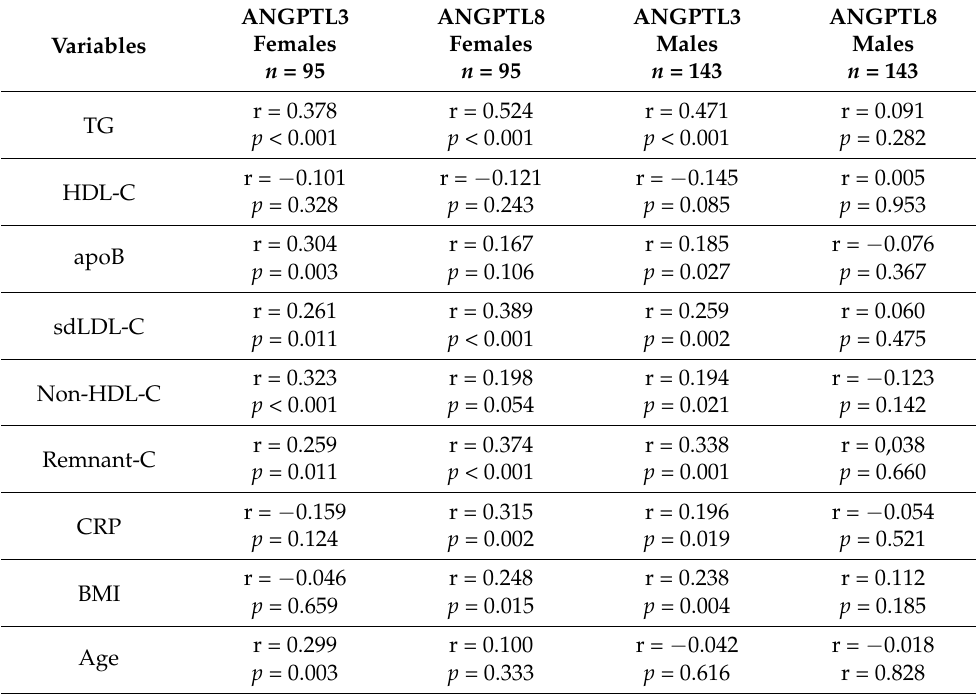
Table 2. Spearman rank correlation coefficients between ANGPTL3 and ANGPTL8, and atherogenic biomarkers by